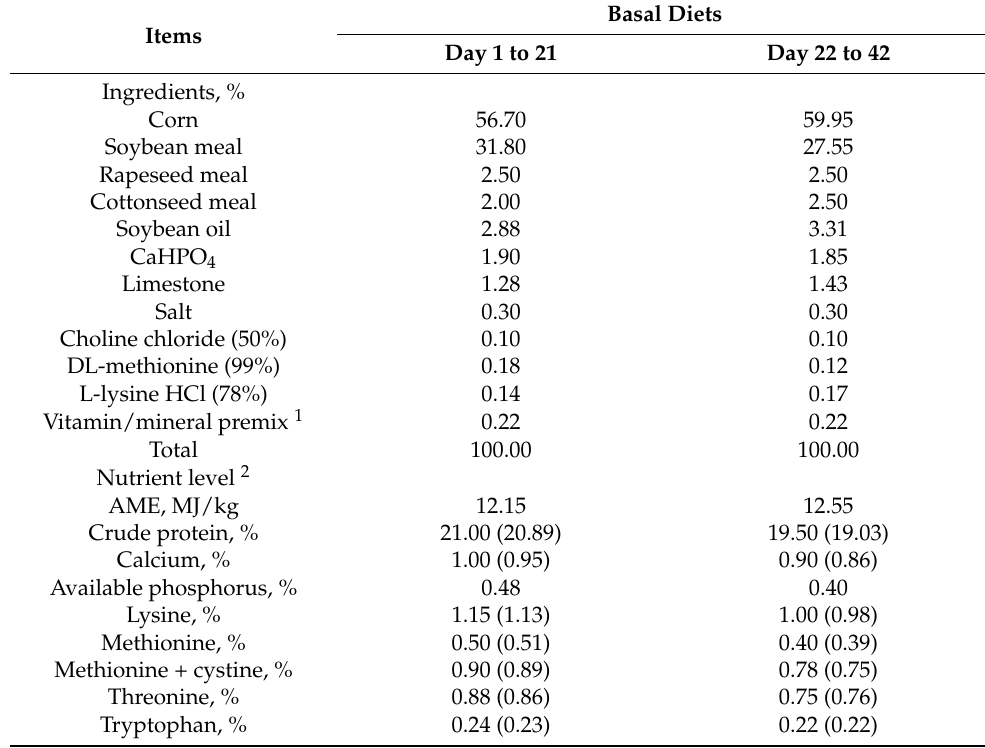
Table 1. Dietary composition and nutrient level of the basal